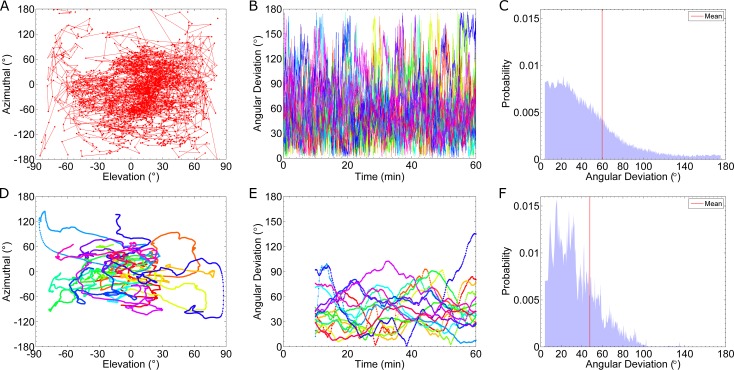
Estimated Angular Deviation from Gradient.Results from sixteen simulations of cells in a 0.1 nM/μm gradient, using the fast binding and unbinding rates: kon = 1.6×106 (M·s)-1 and koff = 0.011 s-1. In this figure we plot the cell’s estimate of the gradient, gest, which is equal to the center of mass of the Ste2* distribution. “Elevation” measures the angle of gest relative to the x-y plane, and “Azimuthal” measures the counterclockwise angle in the x-y plane away from the positive x-axis. The “Angular Deviation” is the angle between the true gradient and gest. (A) Trajectory in the azimuthal-elevation phase plane of a single simulation. (B) Plots of the instantaneous angular deviation from sixteen cells. Each color represents a single simulation result. (C) Histogram of the data in (B). The average angle angular deviation is indicated by the vertical red line; the mean is 59.7°. (D) Time-averaged (10 min) trajectories in the azimuthal-elevation phase plane of sixteen simulations. (E) Plots of the time-averaged angular deviation (10 min). (F) Histogram of the data in (E). The average angular deviation is indicated by the vertical red line; the mean is 47.8°.